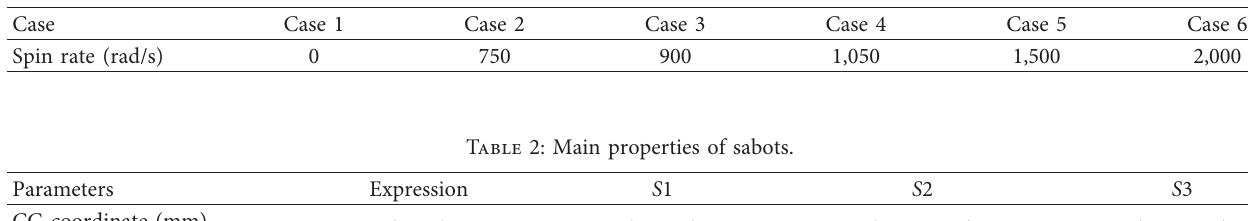
Table 1: Spin rate of the sabot.